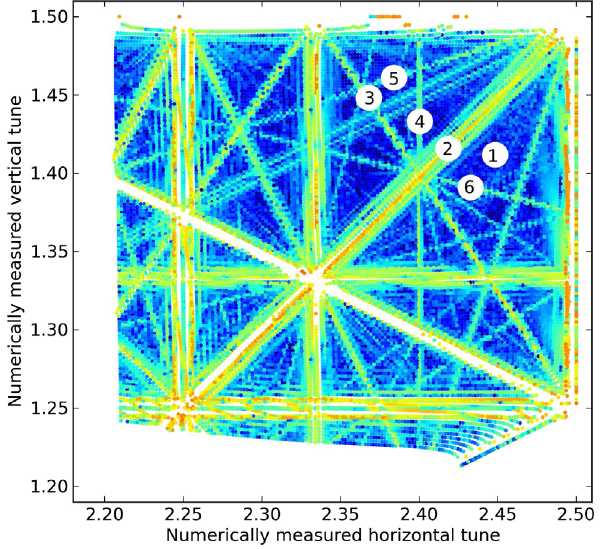
FIG. 8. The numbered white points in the tune diagram indicate the tunes where the dynamic aperture was calculated.